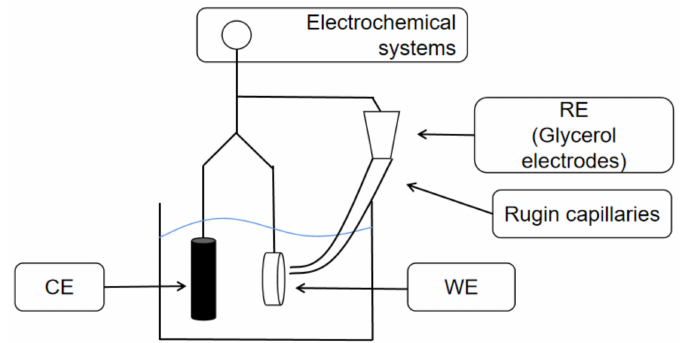
Figure 2. Device